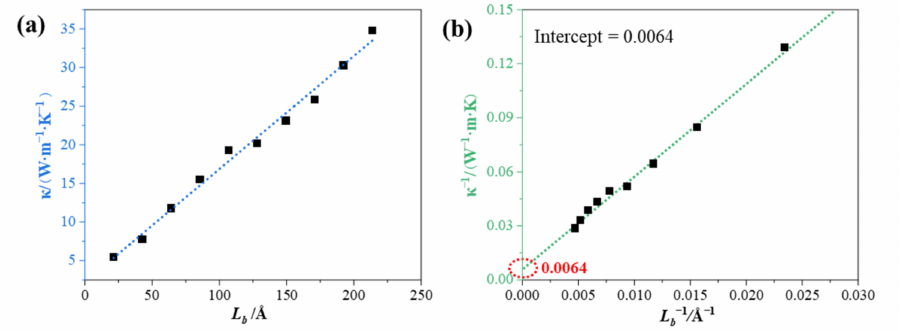
Figure 7. ( a ) Thermal conductivities as a function of the system size. ( b ) Inverse of thermal conduc- tivity as a function of the inverse of the system